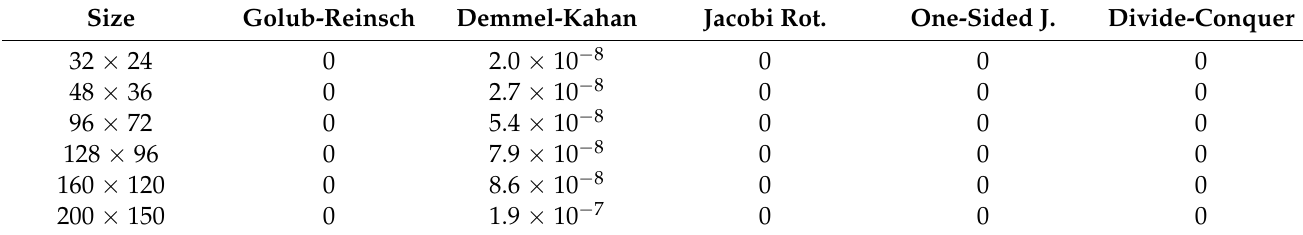
Table 1. Average errors of SVD algorithms implemented in MATLAB vs. MATLAB built-in. Size Golub-Reinsch Demmel-Kahan Jacobi Rot. One-Sided J.